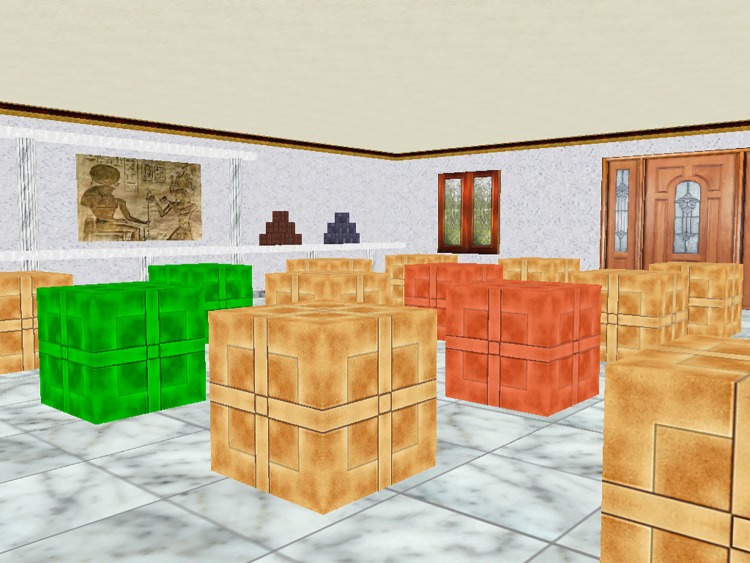
WSBRT.Representative view of the virtual room. Participants have to move into the virtual room to select the rewarded positions. Correct boxes turned green, whereas red indicates wrong boxes. Non-open boxes remained brown. Rewarded positions remained stable during the ten-trial experiment.